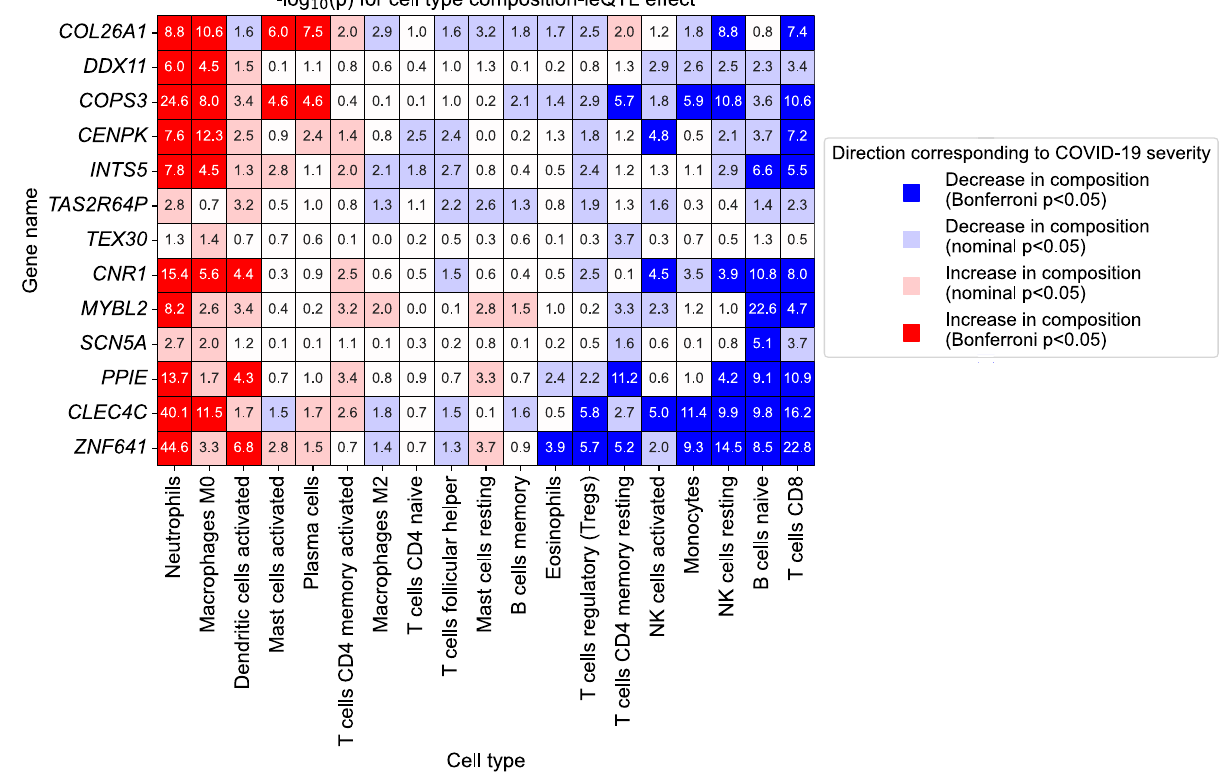
Fig. 8 | COVID-19 severity-interaction eQTLs interacts with composition of various immune cell types. For each of the 13 genes with COVID-19 severity- interaction eGenes (FDR<0.05) (= row), signi fi cance for interaction eQTL effect with inferred cell type compositions (= columns) are plotted in − log 10 ( p ) scale. Colors show the signi fi cance aswell asthe direction of the ieQTL effectrelative to